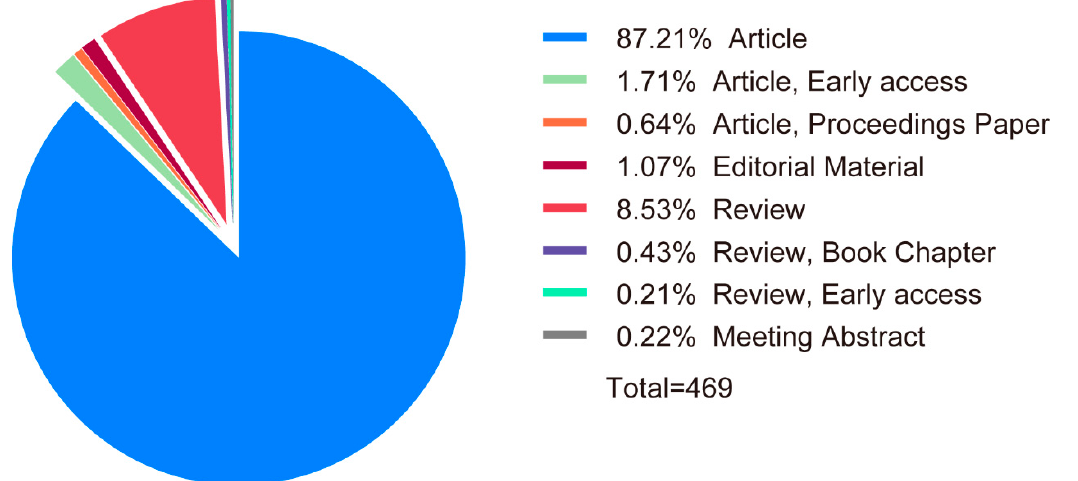
Figure 2. The percentages of seven types of documents.